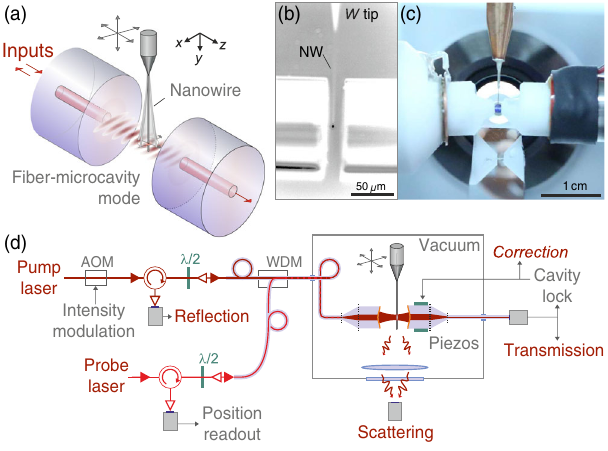
FIG. 1. Experimental setup. (a) Vibrating extremity of a silicon carbide nanowire piezo positioned in the optical mode volume of a high-finesse fiber microcavity to produce a large parametric coupling between the cavity optical mode and the oscillator position. (b,c) Lateral objective serving to align the experiment and collect part of the side-scattered light [dark spot in (b)]. (d) Sketch of the experiment. AOM: acousto-optic modulator; WDM: wavelength dividing